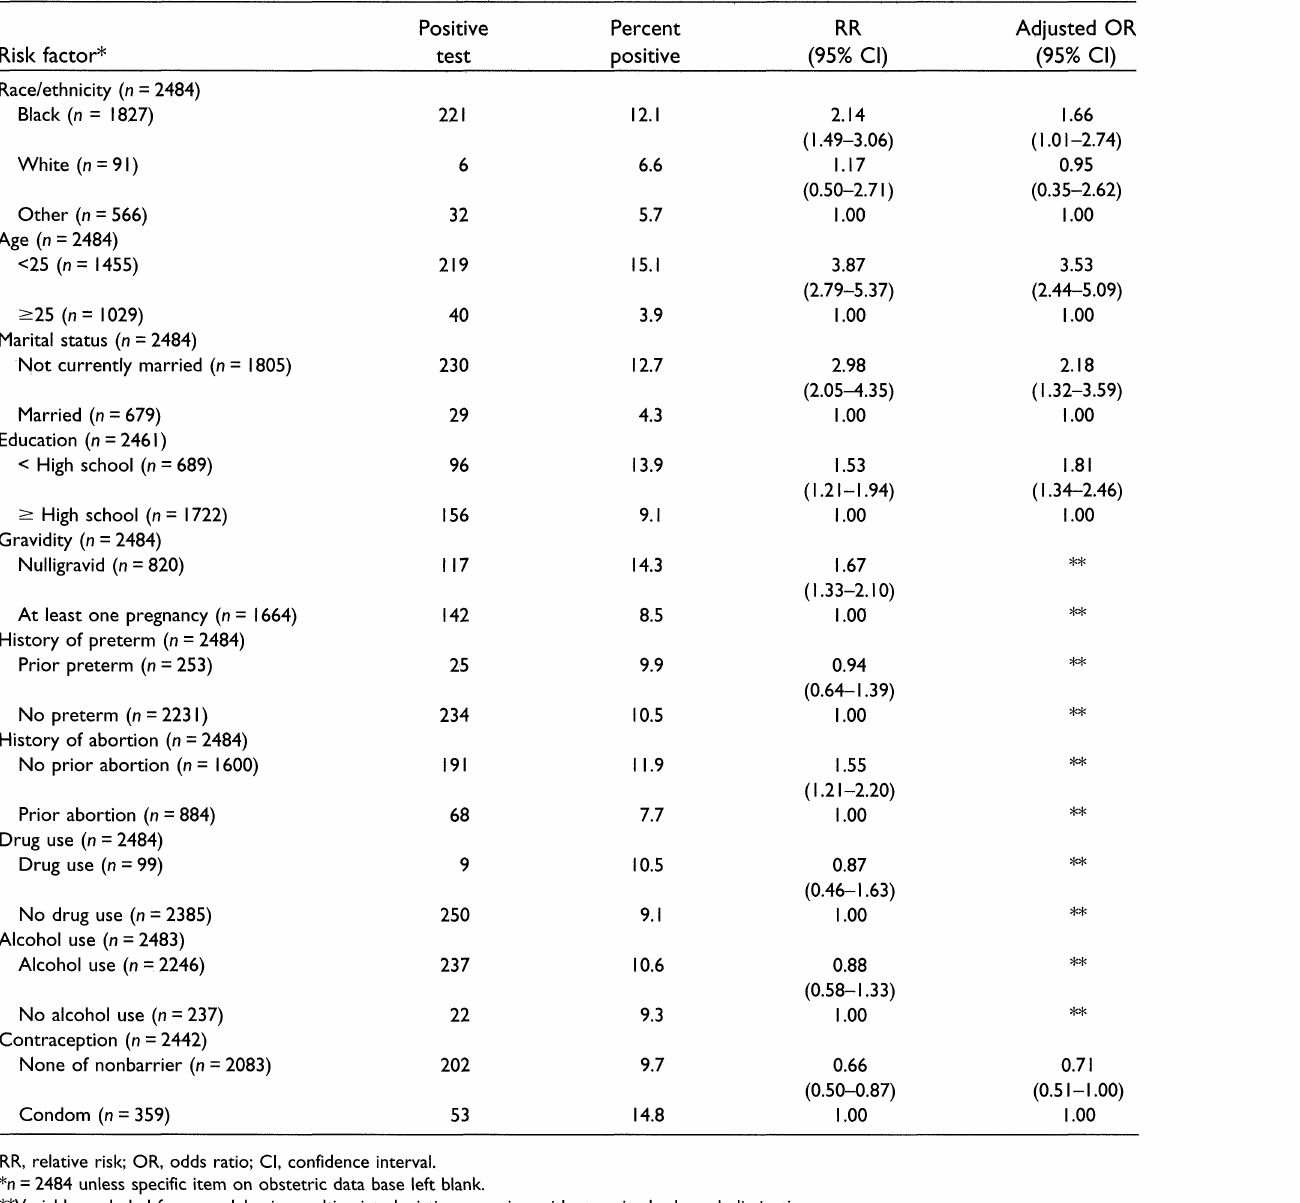
TABLE I. Risk factors associated with a positive initial C. trachomatis test during pregnancy Positive